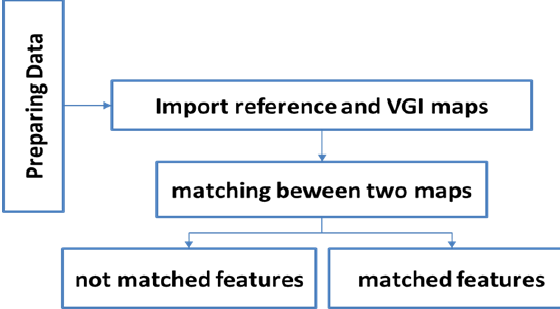
Figure 1: Separating matched and not matched features